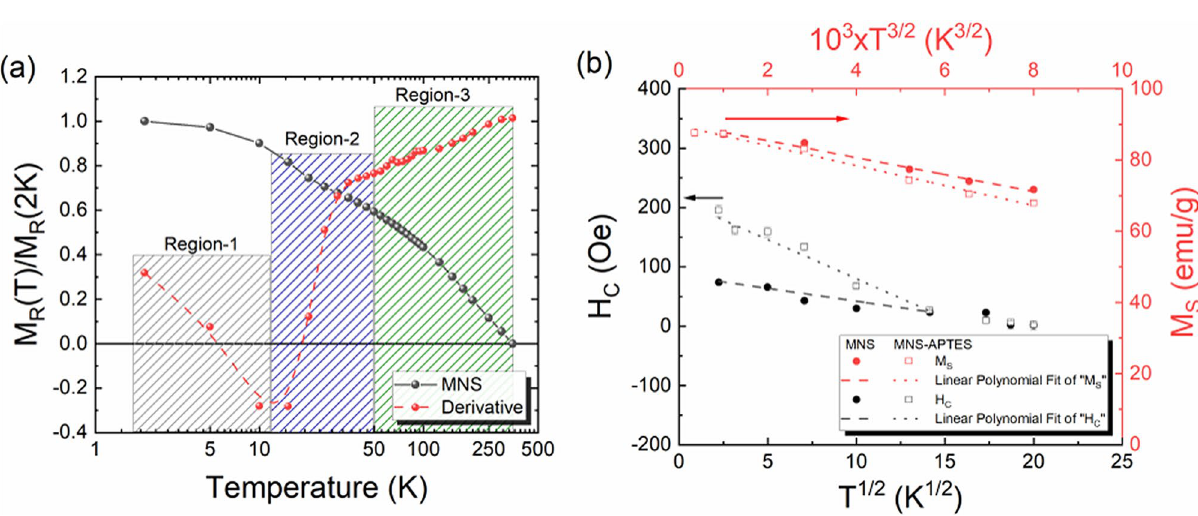
Figure 5. ( a ) The thermoremanent magnetization (black circles) and its first-order derivative (red circles) as a function of temperature, ( b ) The coercive field (H C ) vs. T 1/2 (left vs. bottom axis) and saturation magnetization (M S ) vs. T 3/2 (right vs. top axis) for MNS (circles) and MNS-APTES